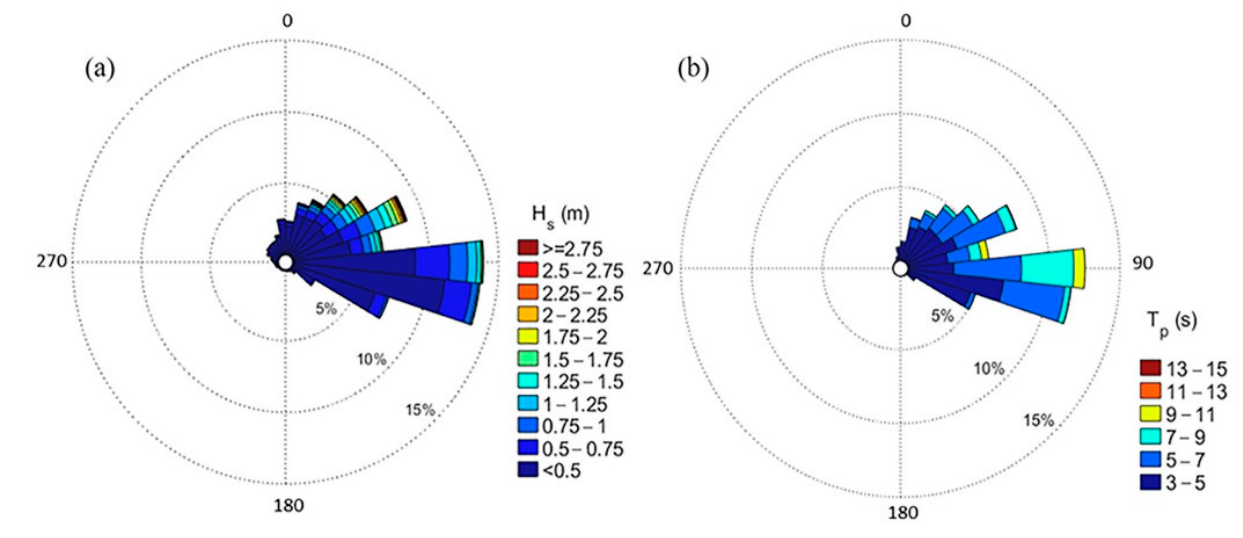
Figure 4. Wave regime from the Nausicaa buoy in the period 2010–2020: distribution with mean wave direction of ( a ) significant wave height (H s ) and ( b ) peak period (T p